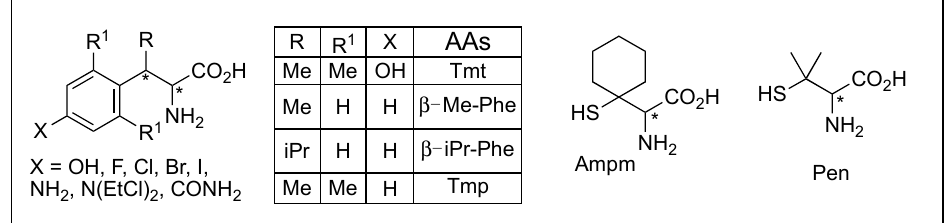
Figure 9. C β -substituted amino acids. * Chiral.